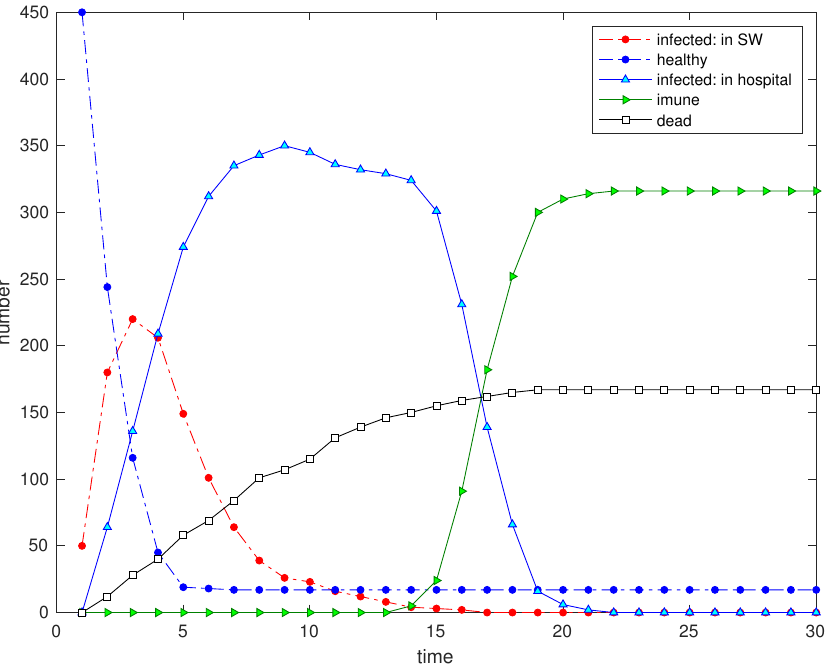
Figure 2. Scenario S 1 : Time evolution of the 5 state variables, for N = 500, n i = 50, D = 0.07, δ = 0.1, p 1 = 0.1, p 2 = 0.9, p 3 = 0.7, p 4 = 0.05, p 5 = 0.02, α = 2 and N h → ∞